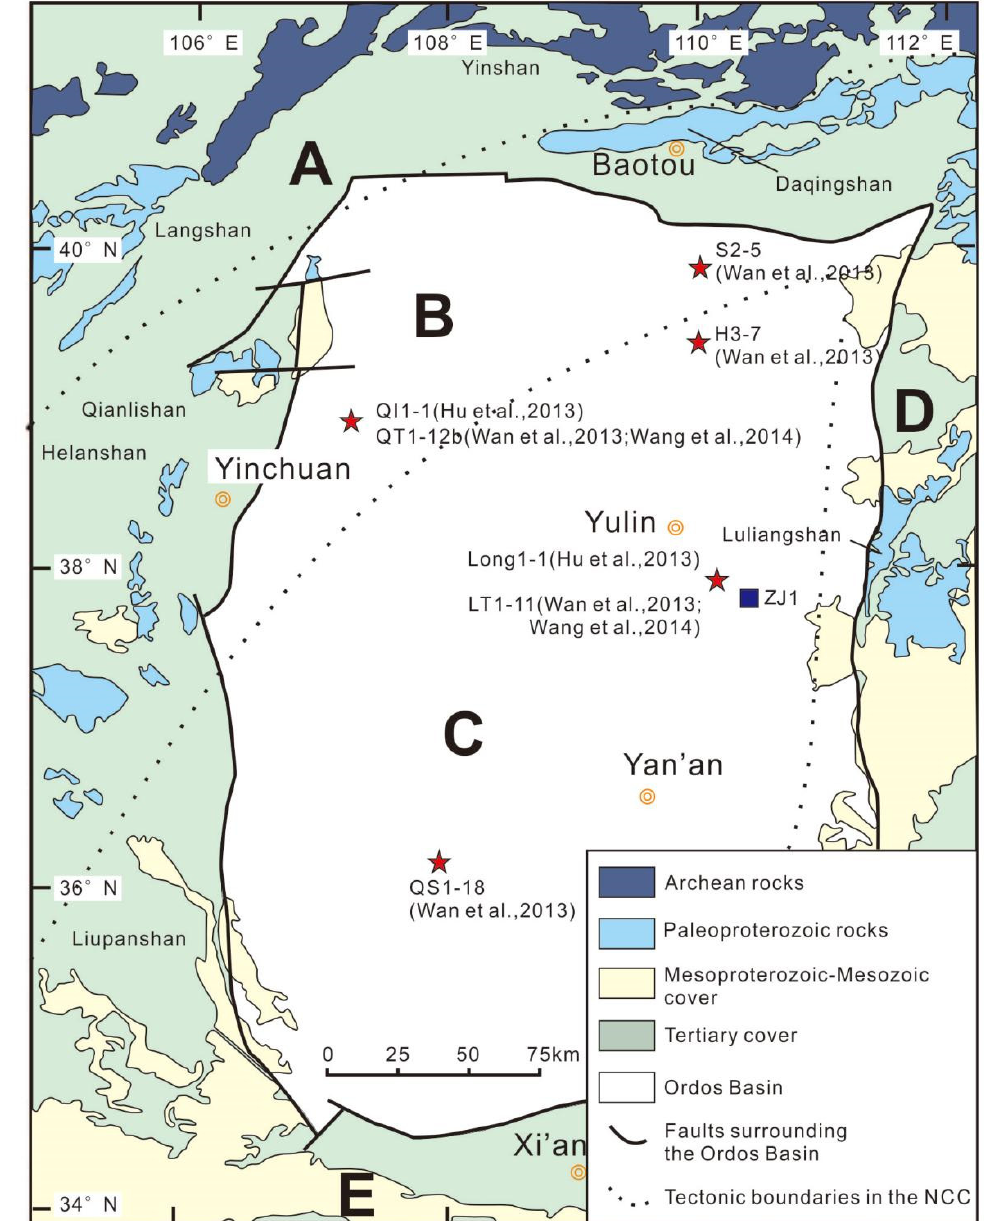
Figure 2. Geological map of the Ordos Basin and surrounding areas [27–29] (modified after Wan et al., 2013), showing the sample location in this study and those of Hu et al., 2013, Wan et al., 2013 and Wang et al., 2014. ( A ): Yinshan Block; ( B ): Khondalite Belt; ( C ): Ordos Block; ( D ): Trans-North China Orogen; ( E ): Qingling Orogen.